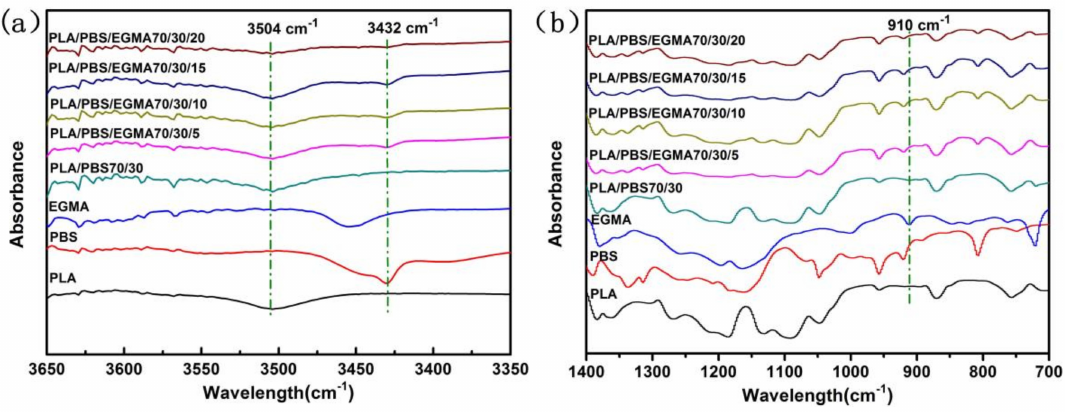
Figure 1. FT-IR spectra of specimens: ( a ) 3650–3350 cm − 1 ; ( b ) 1400–700 cm − 1